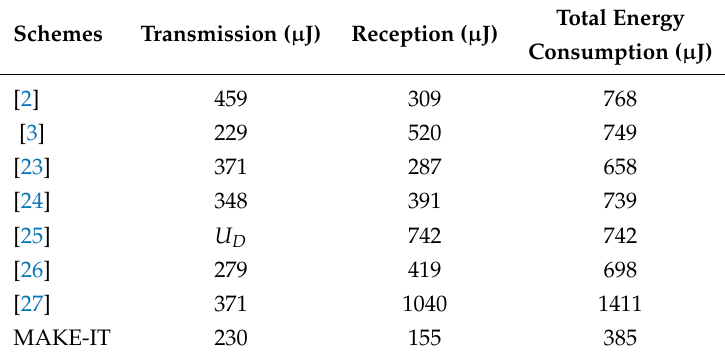
Table 6. Communication energy